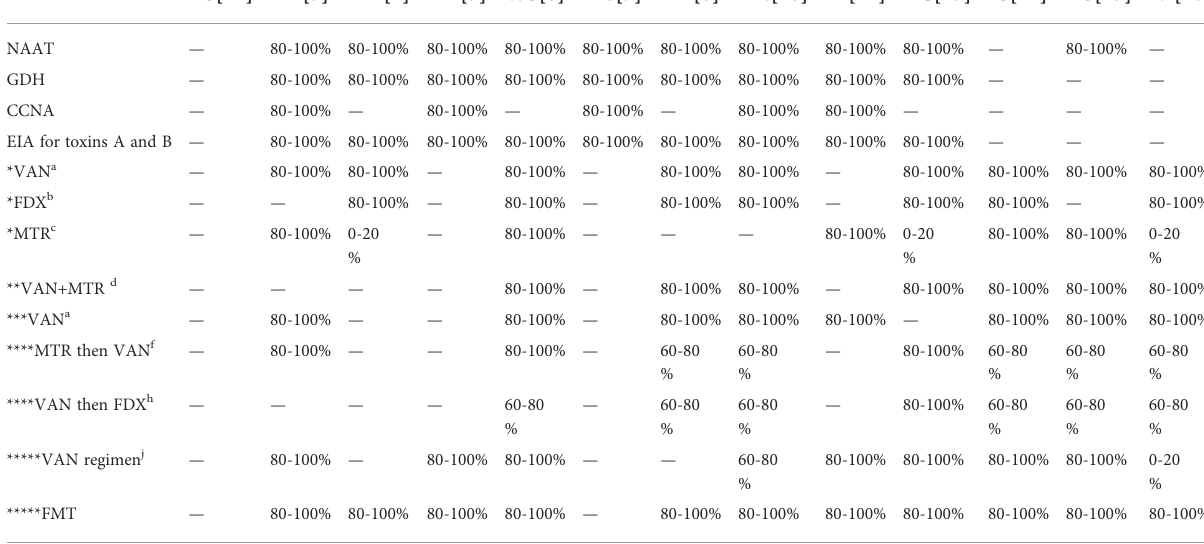
TABLE 4 Scienti fi c agreement offormulated recommendations for the diagnosis and therapy of Clostridium dif fi cile infection in the included